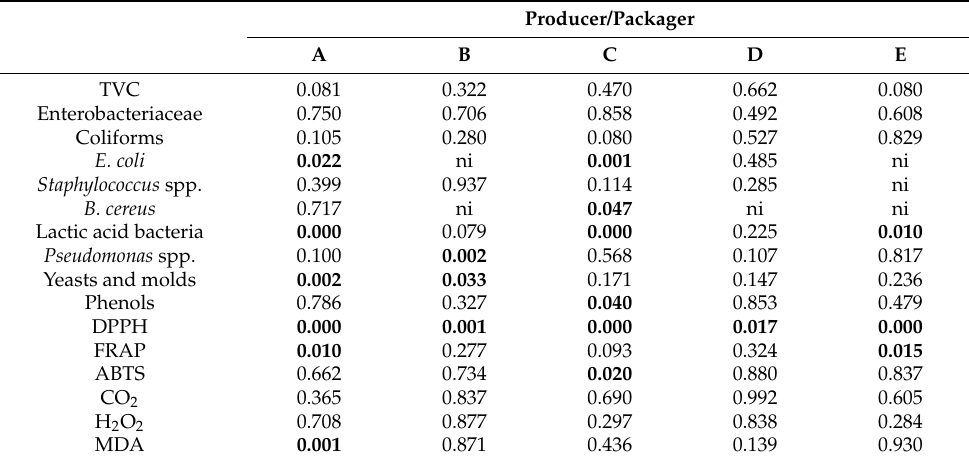
Table 1. Effect of the sampling period (winter–summer) on microbiological load (log cfu/g), total phenolic content (mg GAE/g Fw), antioxidants (mg Trolox/g Fw), % CO 2 and stress markers—H 2 O 2 ( µ mol/g Fw) and MDA (nmol/g Fw) of ready-to-eat salads according to producer/packager (A, B, C, D and